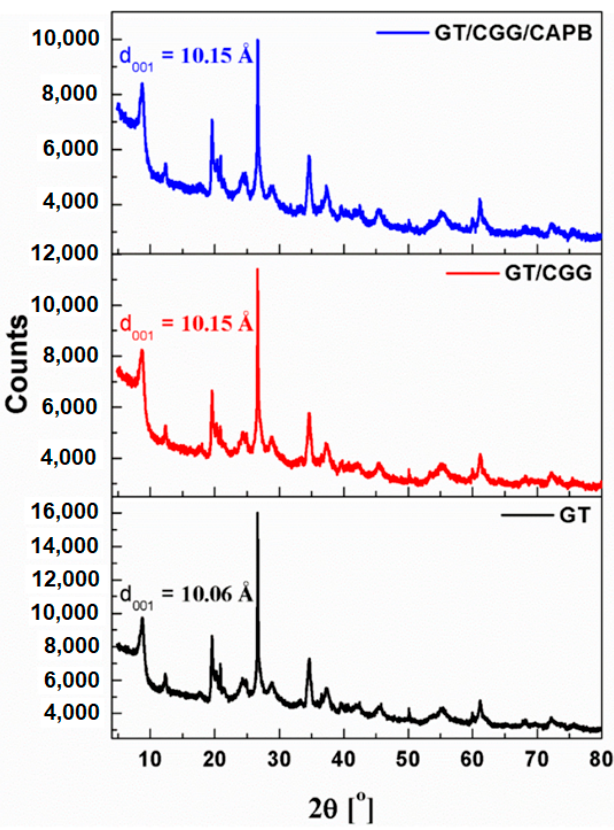
Figure 12. X-ray diffraction patters of glauconite clay GT and GT modified by CGG and the Figure 12. X-Ray diffraction patters of glauconite clay GT and GT modified by CGG and the CGG/CAPB CGG/CAPB mixture.